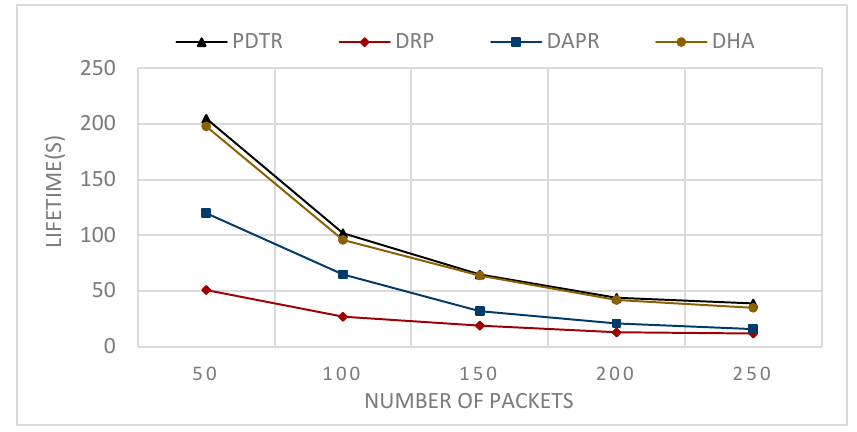
Figure 13. Impact of varying the number of packets on the network lifetime.